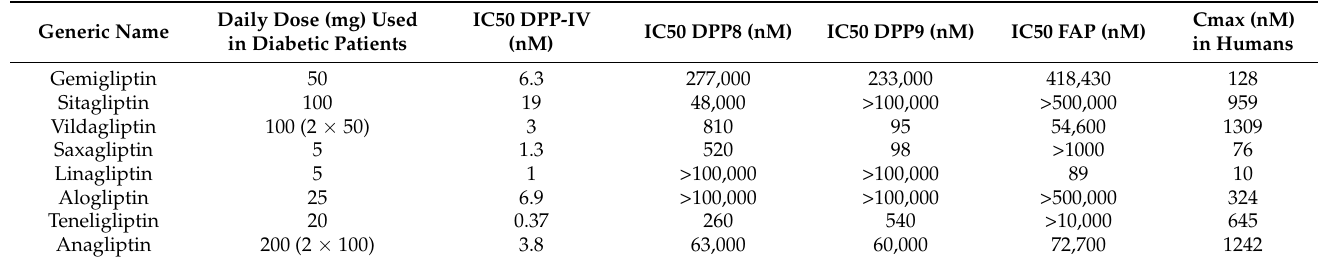
Table 2. Selected pharmacodynamic and pharmacokinetic properties of gliptins evaluated in cancer studies